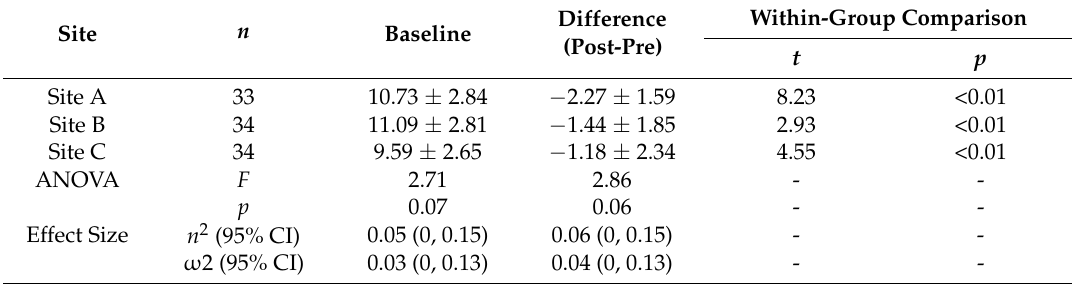
Table 5. Pre- and post-visit comparison of levels of worries across the three sites (n = 101).